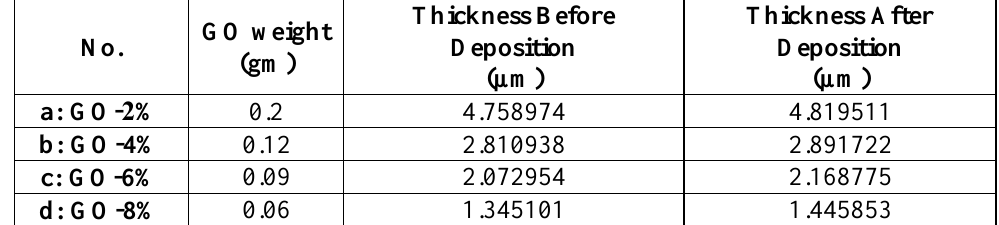
Table 1: Thickness of (G-GO) samples using weight